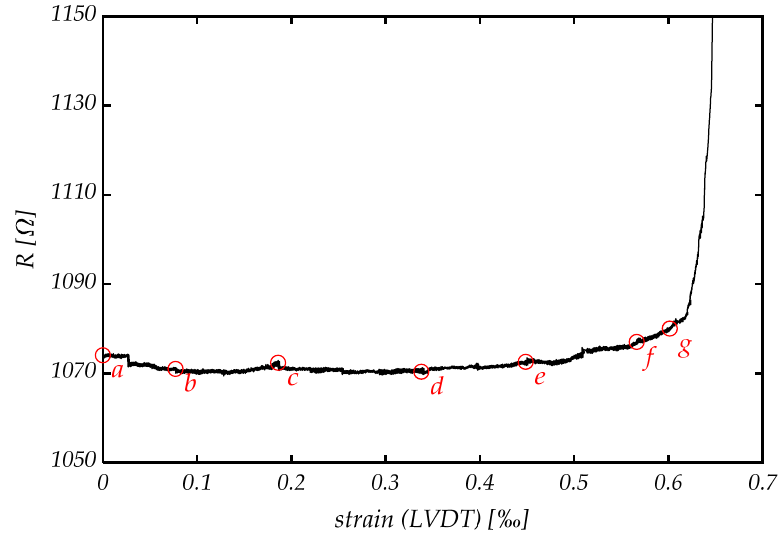
Figure 15. Specimen’s electrical resistance increases especially during plastic deformation after point d . Red circles ( a – g ) indicate the different stages in Figure 13.